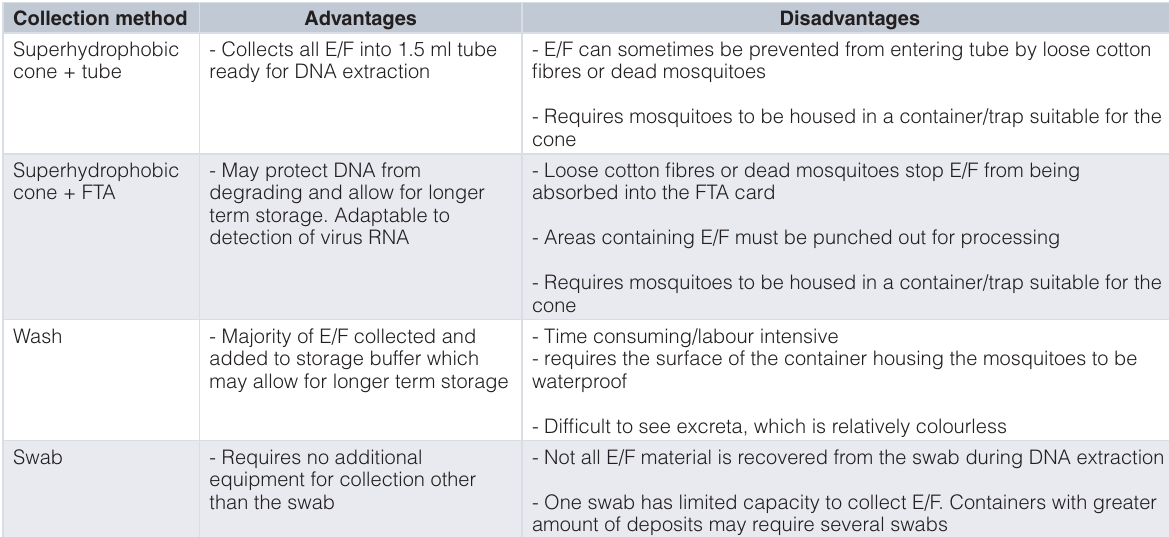
Table 2. Advantages and disadvantages of each excreta/feces (E/F) collection method. Collection method Advantages Disadvantages Superhydrophobic cone + tube